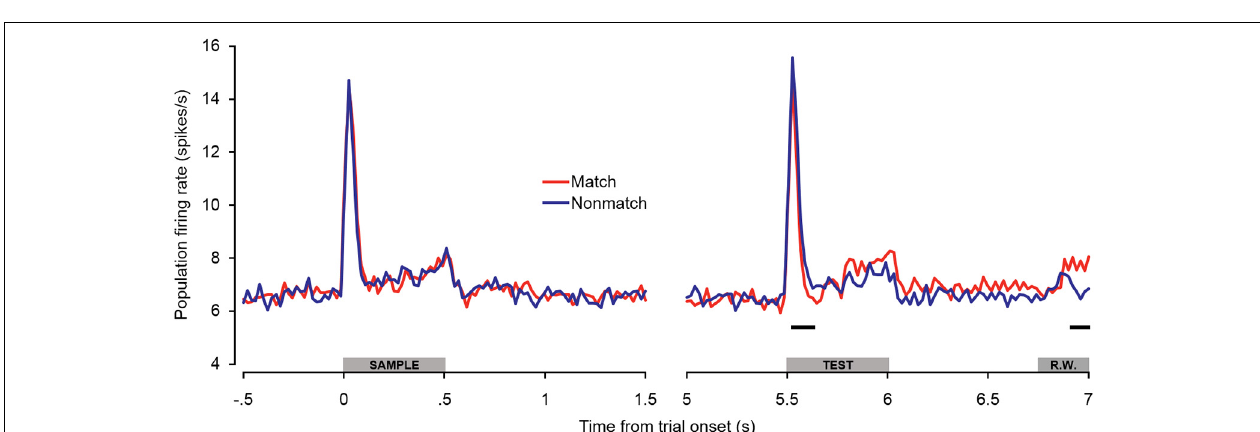
pre-response wait periods. The black bars below the firing rate histograms indicate significant differences between trial types (assessed with a 100-ms sliding window, advancing in 20-ms steps). Differences were only accepted if significant effects were obtained for two or more consecutive steps. The gray bars above the abscissae indicate the sample and test stimulus presentation periods (0–500ms from cue onset) as a well as the onset of the response window (R.W.).